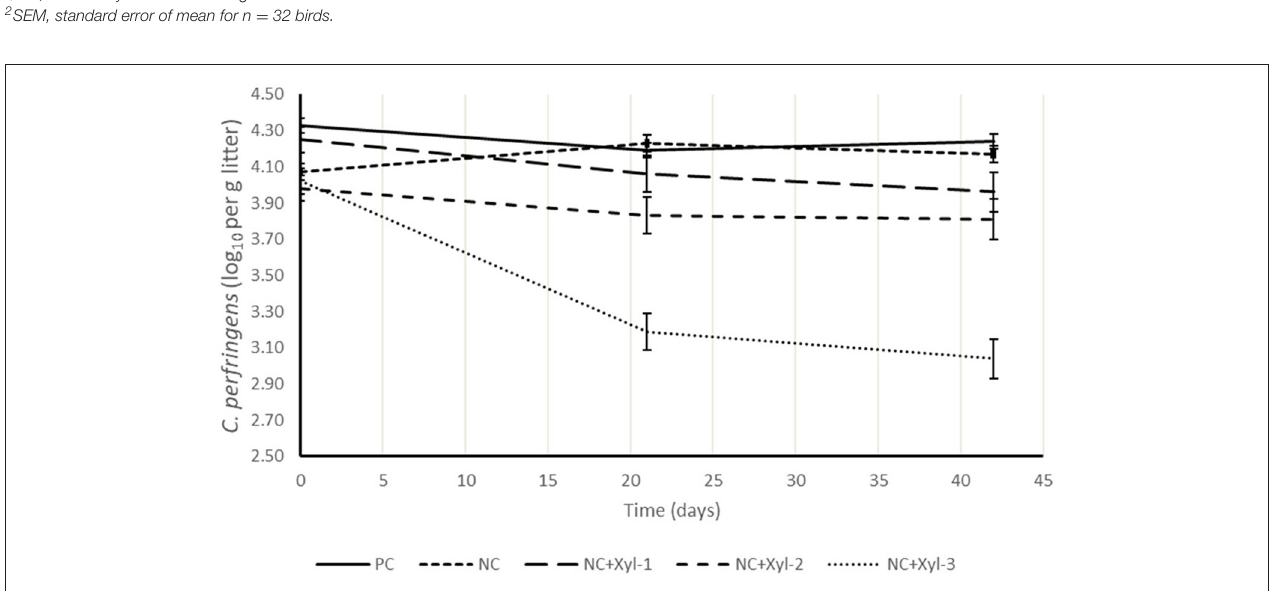
FIGURE 1 | Clostridium perfringens in litter samples collected at 0, 21, and 42 d. Experimental diets. 1 PC, positive control; NC, negative control with ME 130 kcal/kg lower than PC; NC + 10, NC with xylanase at 10 XU/g of feed; NC + 12.5, NC with xylanase at 12.5 XU/g of feed; NC + 15, NC with xylanase at 15 XU/g of feed